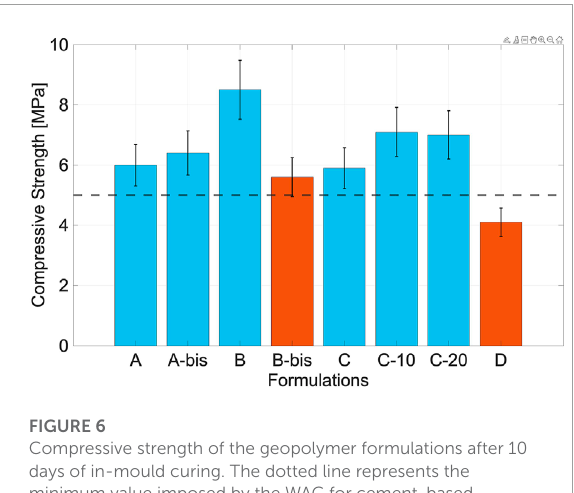
FIGURE 6 Compressive strength of the geopolymer formulations after 10 days of in-mould curing. The dotted line represents the minimum value imposed by the WAC for cement-based